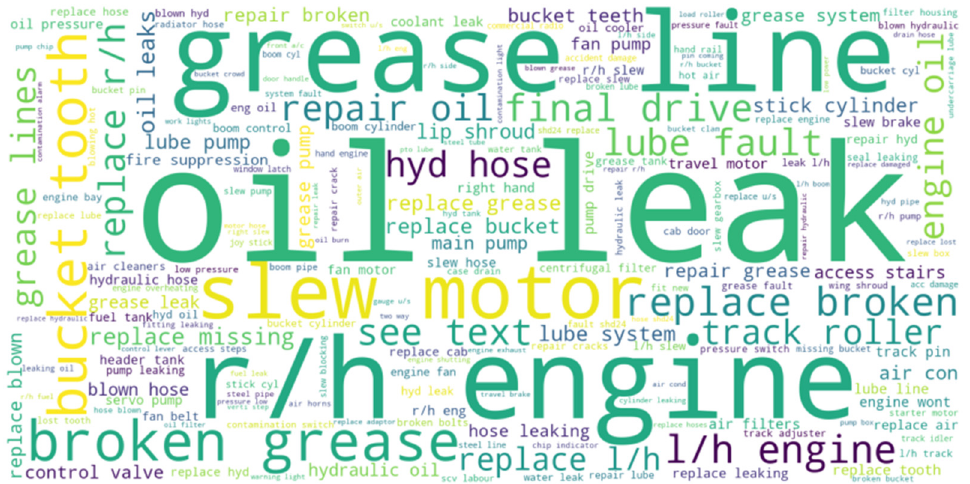
Figure 3. Word cloud of maintenance records.